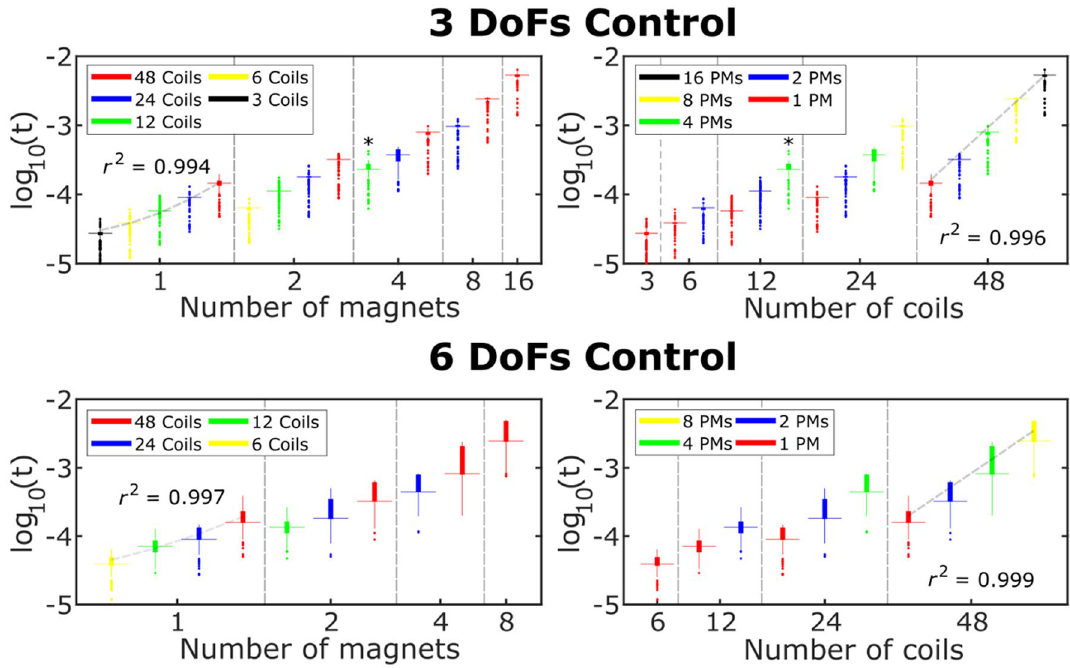
Figure 3. Control matrices computation time. The distribution of the computation time as a function of the number of coils with fixed magnets (left panels) or magnets with fixed coils (right panels), for the 3-DoF (force or torque) and 6-DoF (force and torque) control. The left plots were fitted using a linear function ( t(N) = mN + b , m = 23.442 ± 0.991). The plots on the right were fitted using a power function ( t(C) = kC p , p = 1.314 ± 0.087). The coefficient of determination ( r 2 ) is indicated for some representative cases. *Indicates the implemented